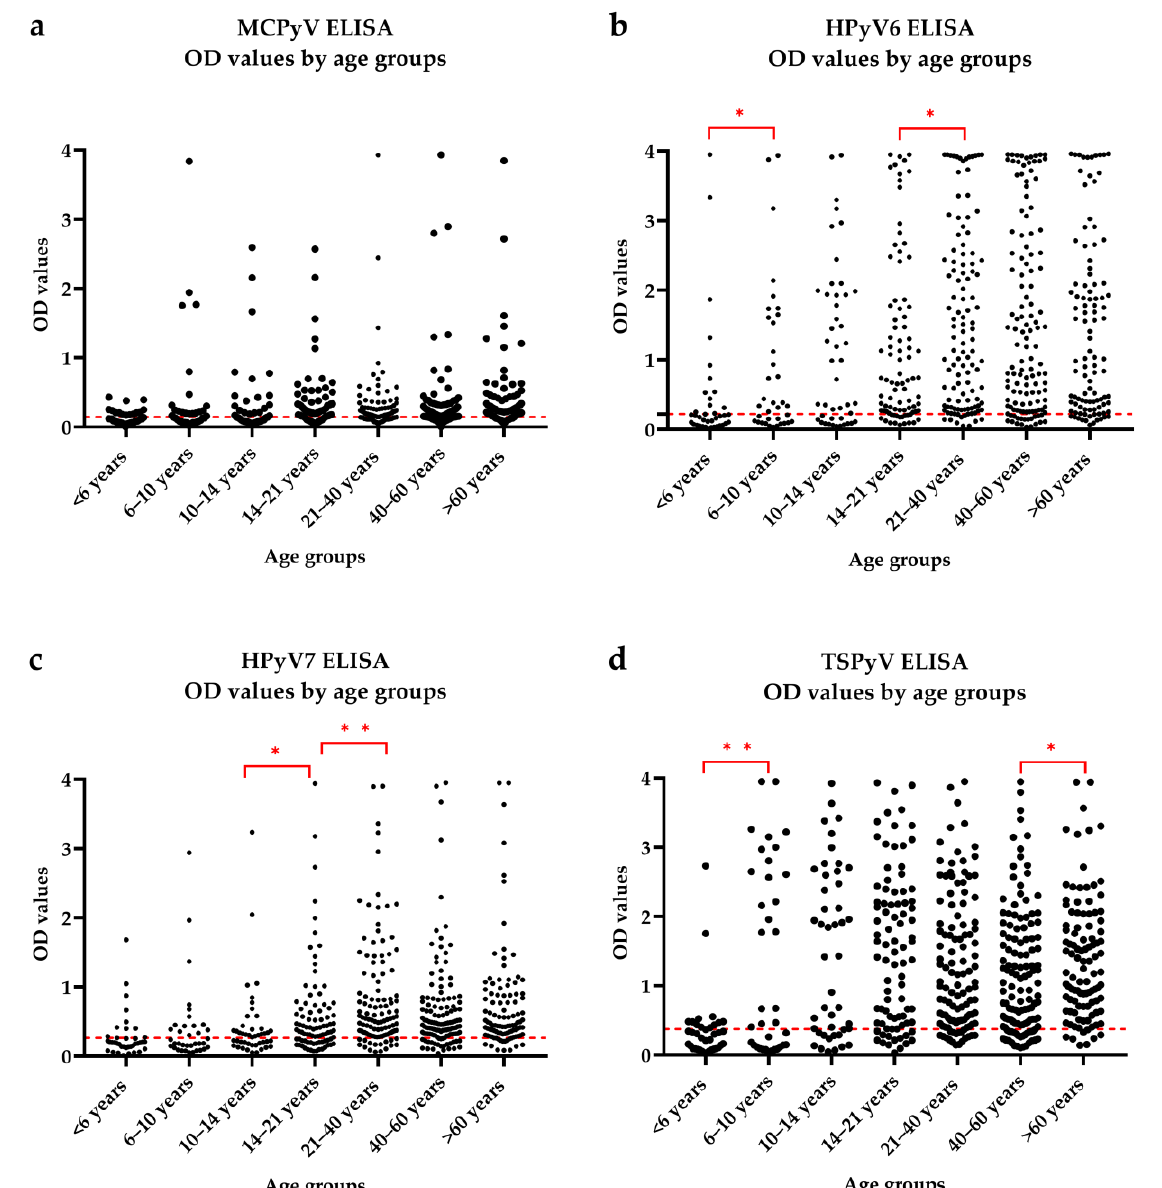
Figure 2. Age distribution of seroresponses against the major capsid proteins of MCPyV ( a ), HPyV6 ( b ), HPyV7 ( c ) and TSPyV ( d ). Each dot represents the optical density (OD) value of an individual serum sample measured with the enzyme-linked immunosorbent assay (ELISA). The cut-off values are shown by red dashed lines, which serve as thresholds for seropositivity. Significant differences in seroreactivity between age groups are presented with red lines and asterisks (Mann–Whitney test, * p ≤ 0.05, ** p ≤ 0.01).